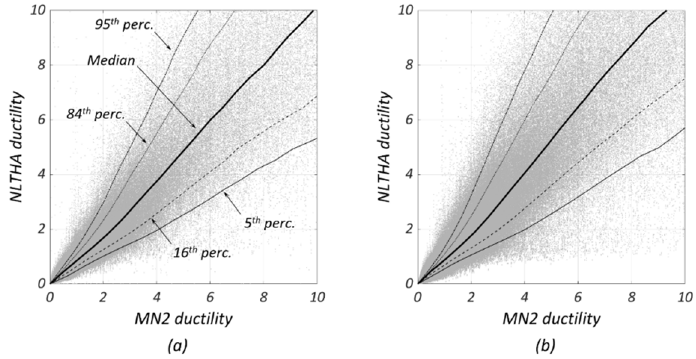
Figure 14. Comparison between ductility demands from the MN2 method and from NLTHA: ( a ) Suite 1-A, and ( b ) Suite 1-B.